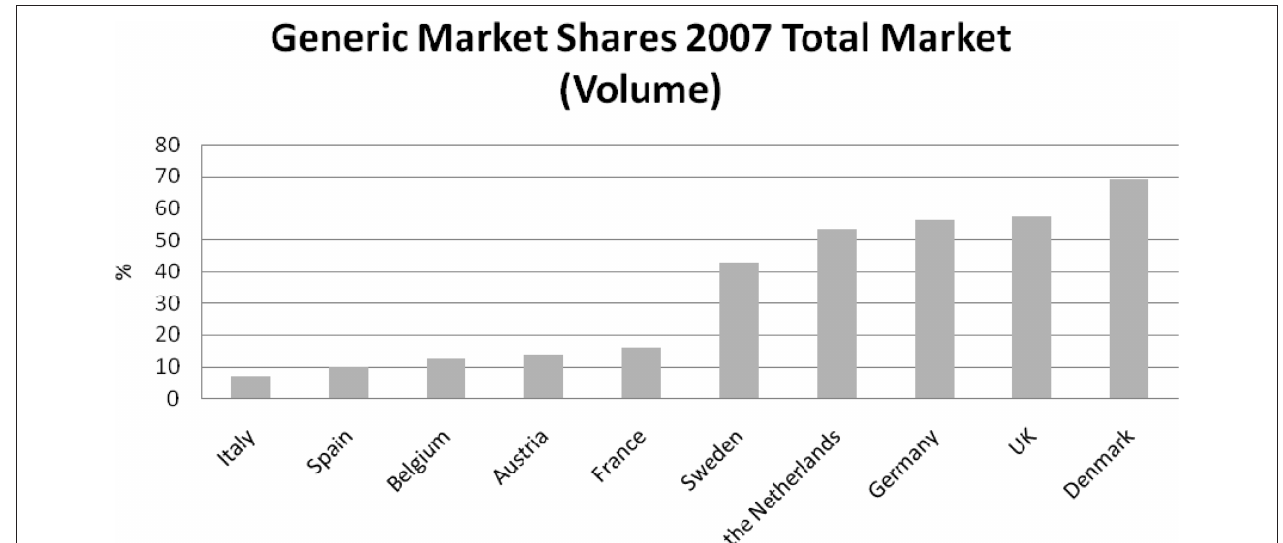
Figure 2 | generic market shares by volume of total medicines market in